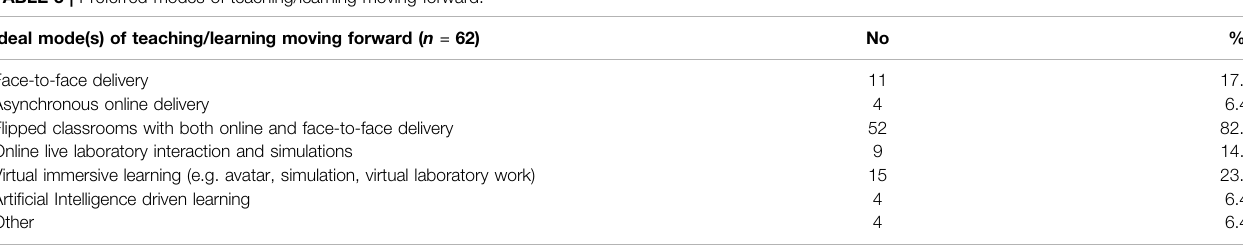
TABLE 3 | Preferred modes of teaching/learning moving